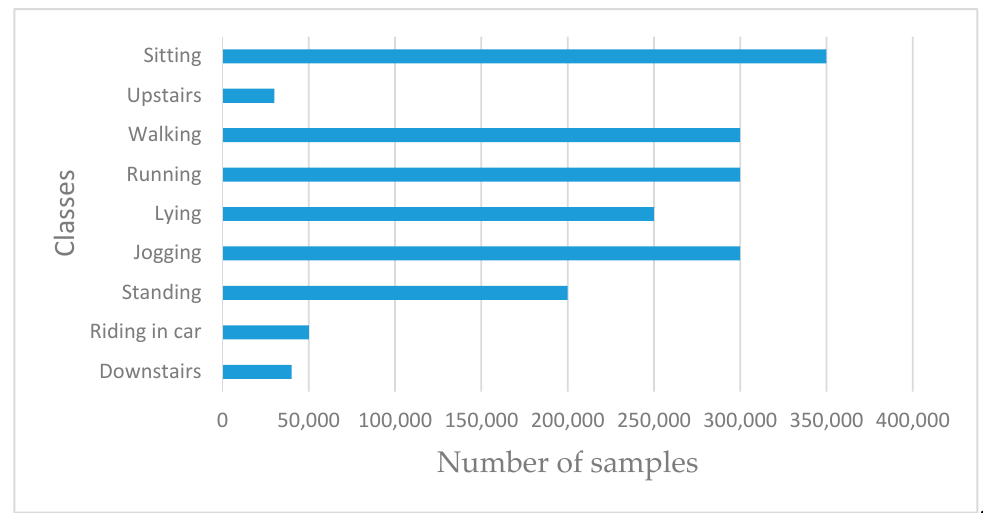
Figure 12. Distribution of classes by number of samples.